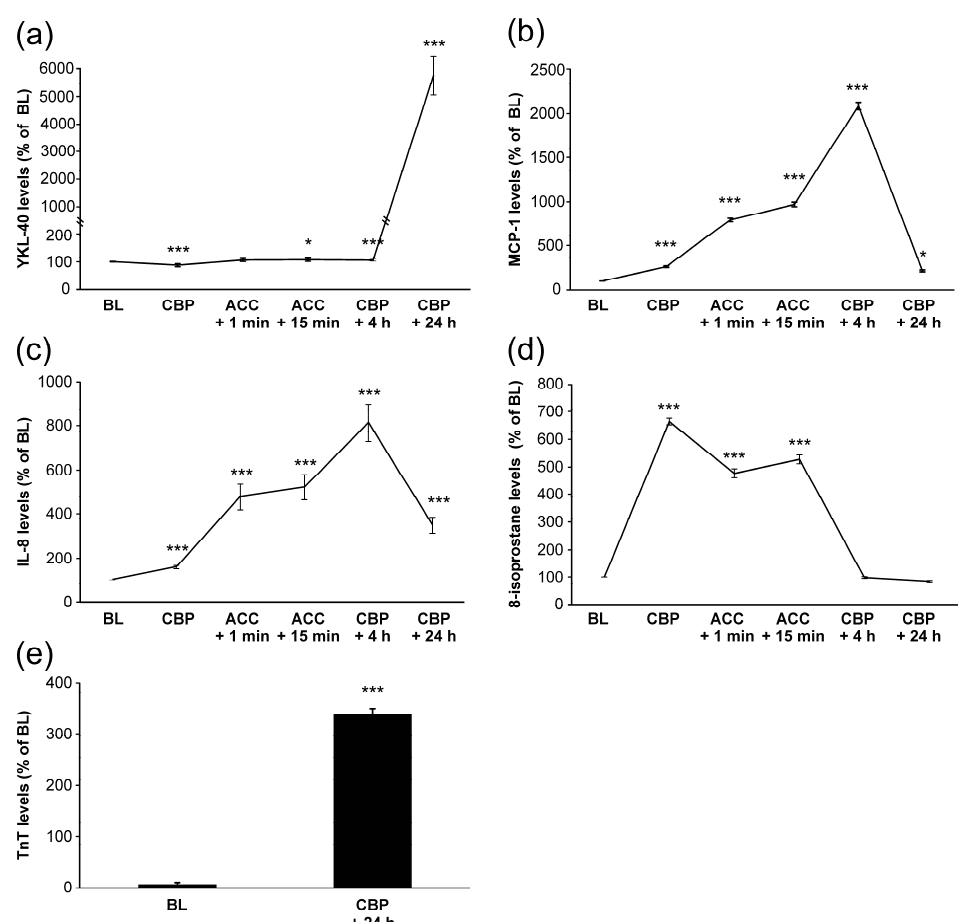
Figure 1. Levels of YKL-40 ( a ), monocyte chemotactic protein-1 (MCP-1, ( b )), interleukin-8 (IL-8, ( c )), 8-isoprostane ( d ) and troponin T (TnT, ( e )) during and after coronary artery bypass grafting operation. Samples were drawn from the radial artery at the following time points: onset of anesthesia (baseline, BL), onset of cardiopulmonary bypass (CPB), 1 min after removal of aortic cross clamp (ACC + 1 min), 15 min after removal of ACC (ACC + 15 min), 4 h after onset of CPB (CPB + 4 h) and 24 h after onset of CPB (CPB + 24 h). Results are presented as mean + SEM, n = 28 patients. * = p < 0.05, *** = p < 0.001. Table 2. Correlations between baseline (Base) and maximum (Max) YKL-40 levels and baseline levels, maximum levels and areas under curve (AUC) of monocyte chemotactic protein-1 (MCP-1), interleukin-8 (IL-8), 8-isoprostane and troponin T (TnT). MCP-1 (pg/mL) IL-8 (pg/mL) 8-Isoprostane